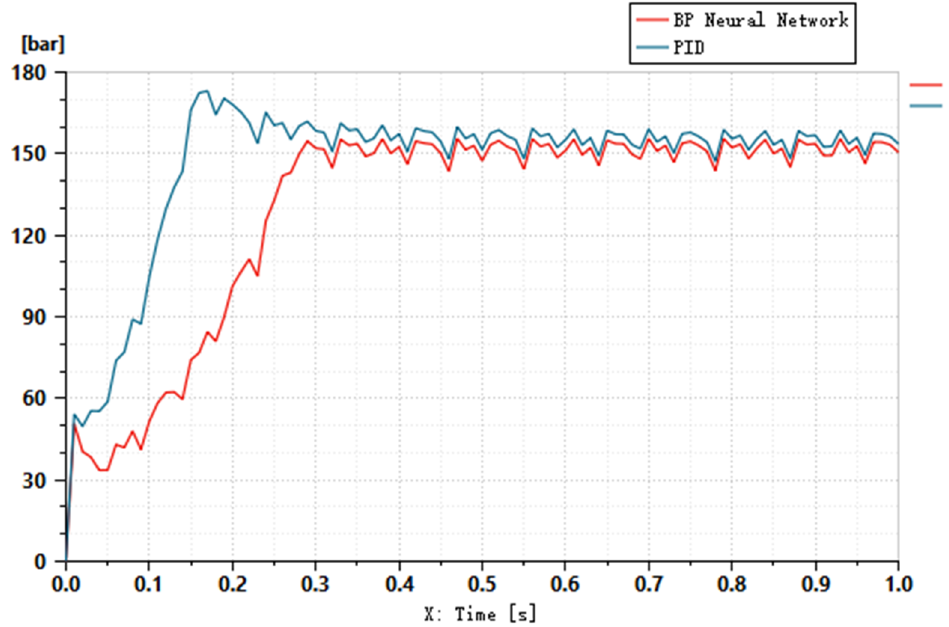
Figure 7. Comparison curve between PID algorithm and BP neural network algorithm.